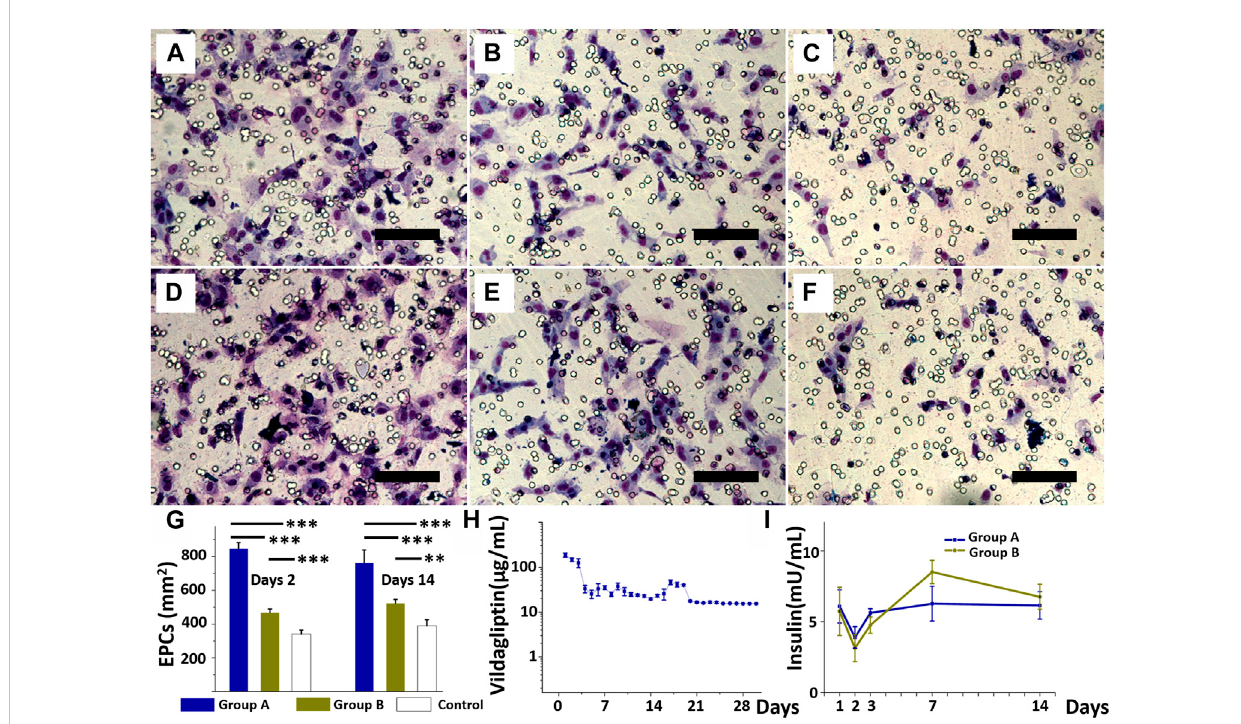
FIGURE 4 EPCs treated with the eluate on day 2 (A, B, and C) and eluate on day 14 (D, E, and F) from insulin/vildagliptin-eluting group (A and D) , EPCs treated with eluents from insulin/PLGA group (B and E) , and control group (C and F) . EPC migration in three groups treated with days 2 or days 14 eluents (G) .